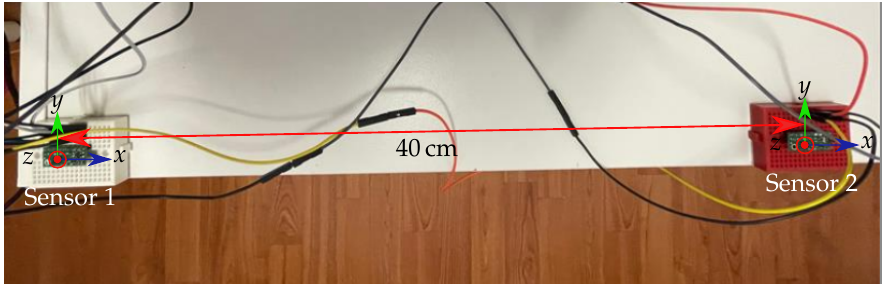
Figure 6. Measurement setup of a representative sensor pair. Sensors 1 and 2 are approximately equally